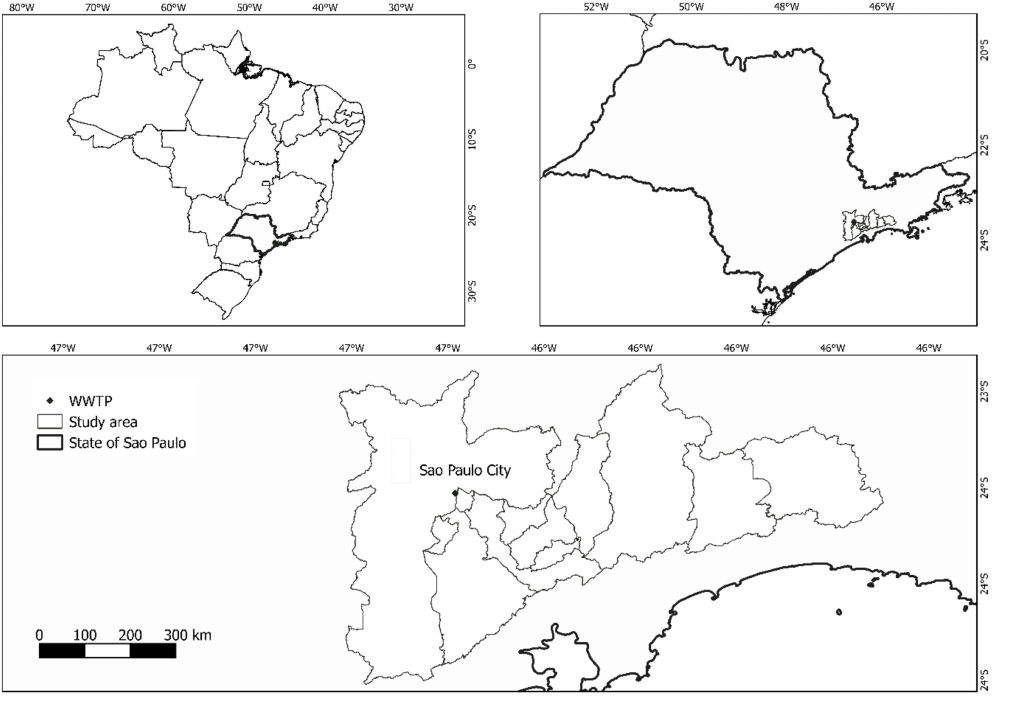
Figure 2. Map of the study area.